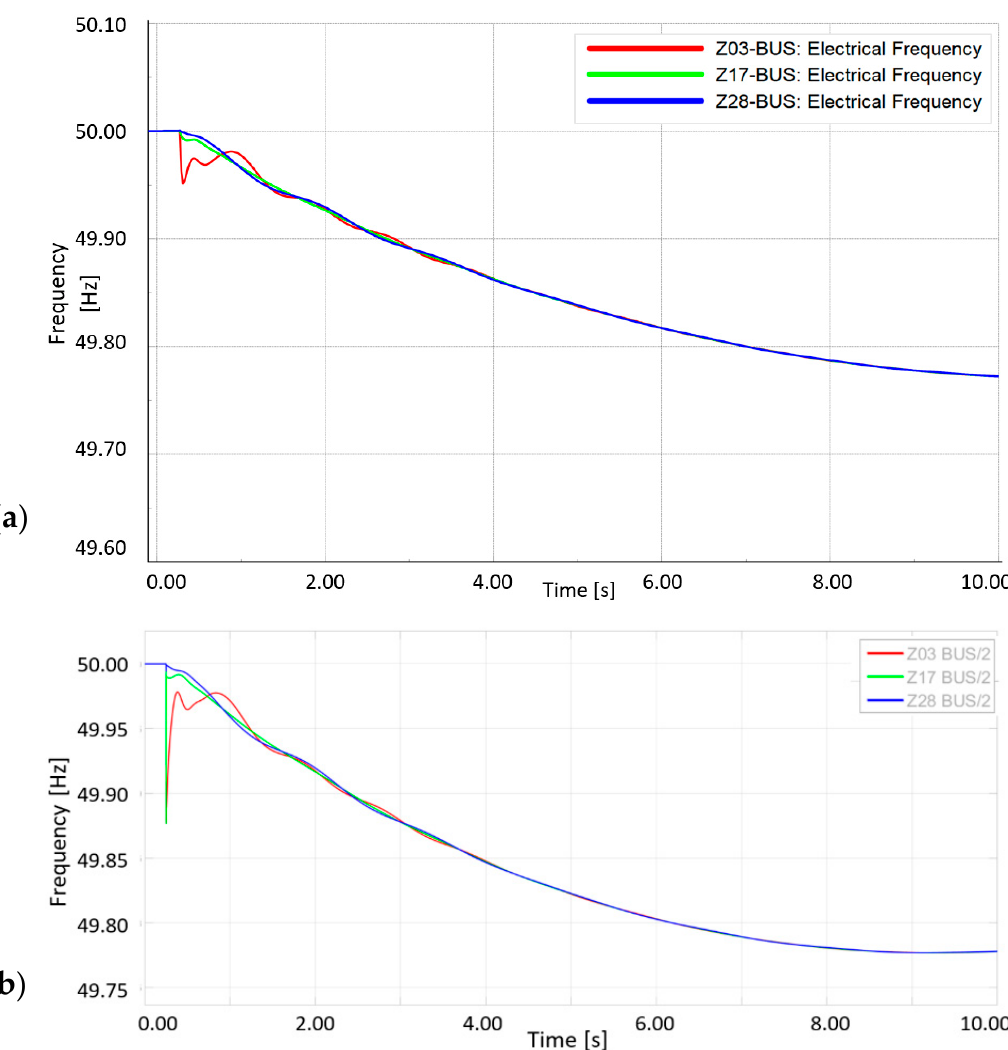
Figure 12. Frequency response of the reduced model for the HVDC trip for zones 03, 17, and 28: ( a ) PowerFactory and ( b ) ePHASORSIM